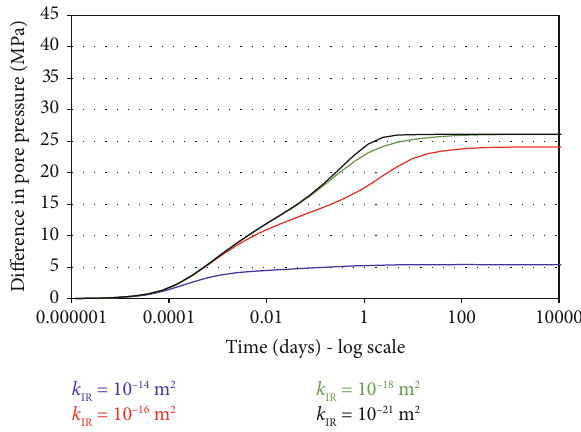
Figure 7: Variation with time of the di ff erence in the fl uid pore pressure between the injection and production boreholes, obtained with consideration of hydrological (H) and thermohydrological (TH) e ff